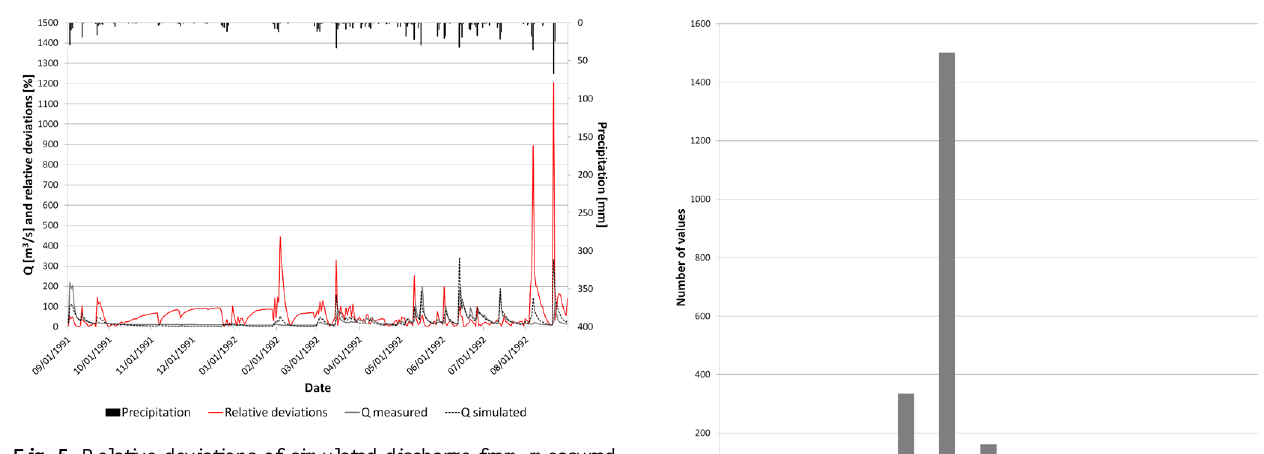
Fig. 5. Relative deviations of simulated discharge from measured discharge (%), Measured and simulated discharge (m 3 s − 1 ) and pre- cipitation (mm) during the time period from 1 September 1991 to 31 August 1992.